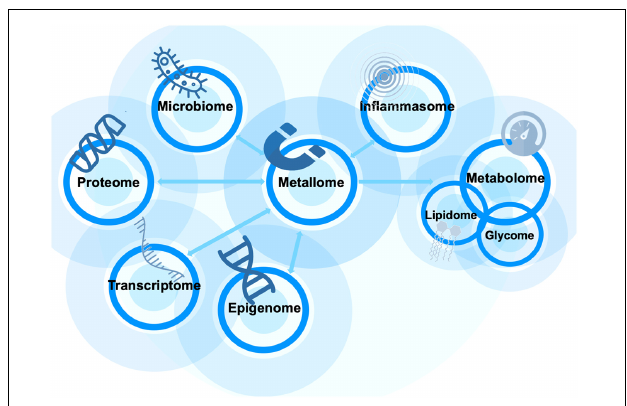
FIGURE 1 | The metallome’s role in ASD can be expanded through its interactions with various other “omes.” Each arrow indicates a significant relationship whereby dyshomeostasis and further alterations in one impact other “omes”